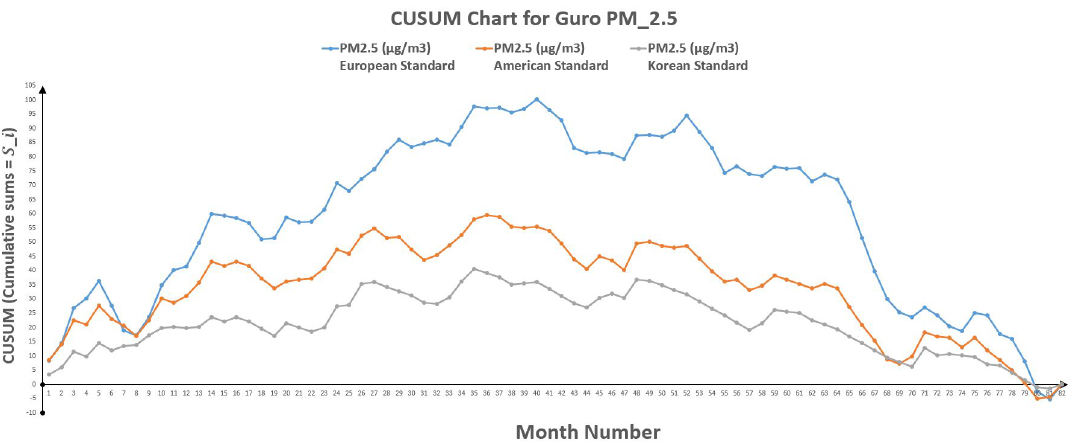
Figure 2. CUSUM chart for Guro PM 2.5 .